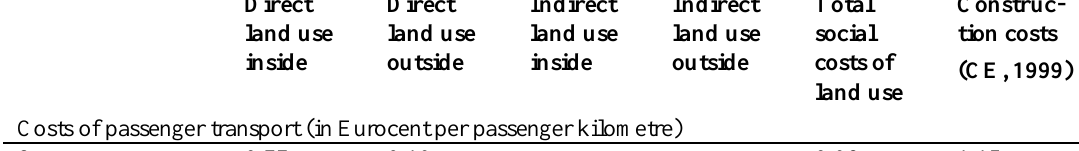
Table 8. Average social costs of land use and the construction of transport infrastructure for passenger and goods